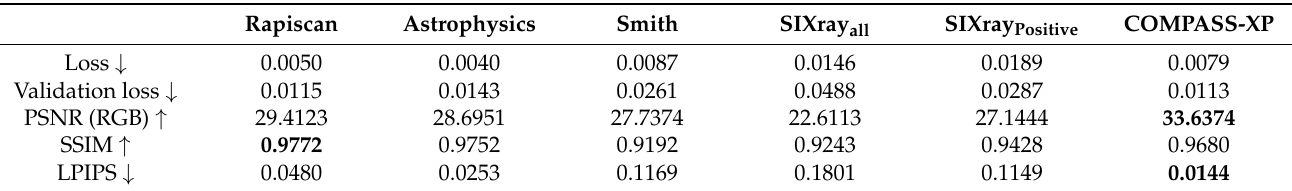
Table 3. Comparison of the colorization performance between Rapiscan, Astrophysics, Smith, SIXray all , SIXray Positive, and COMPASS-XP datasets in terms of PSNR, SSIM, and LPIPS. The best values of PSNR are 33.6374, SSIM is 0.9772, and LPIPS is 0.0144.